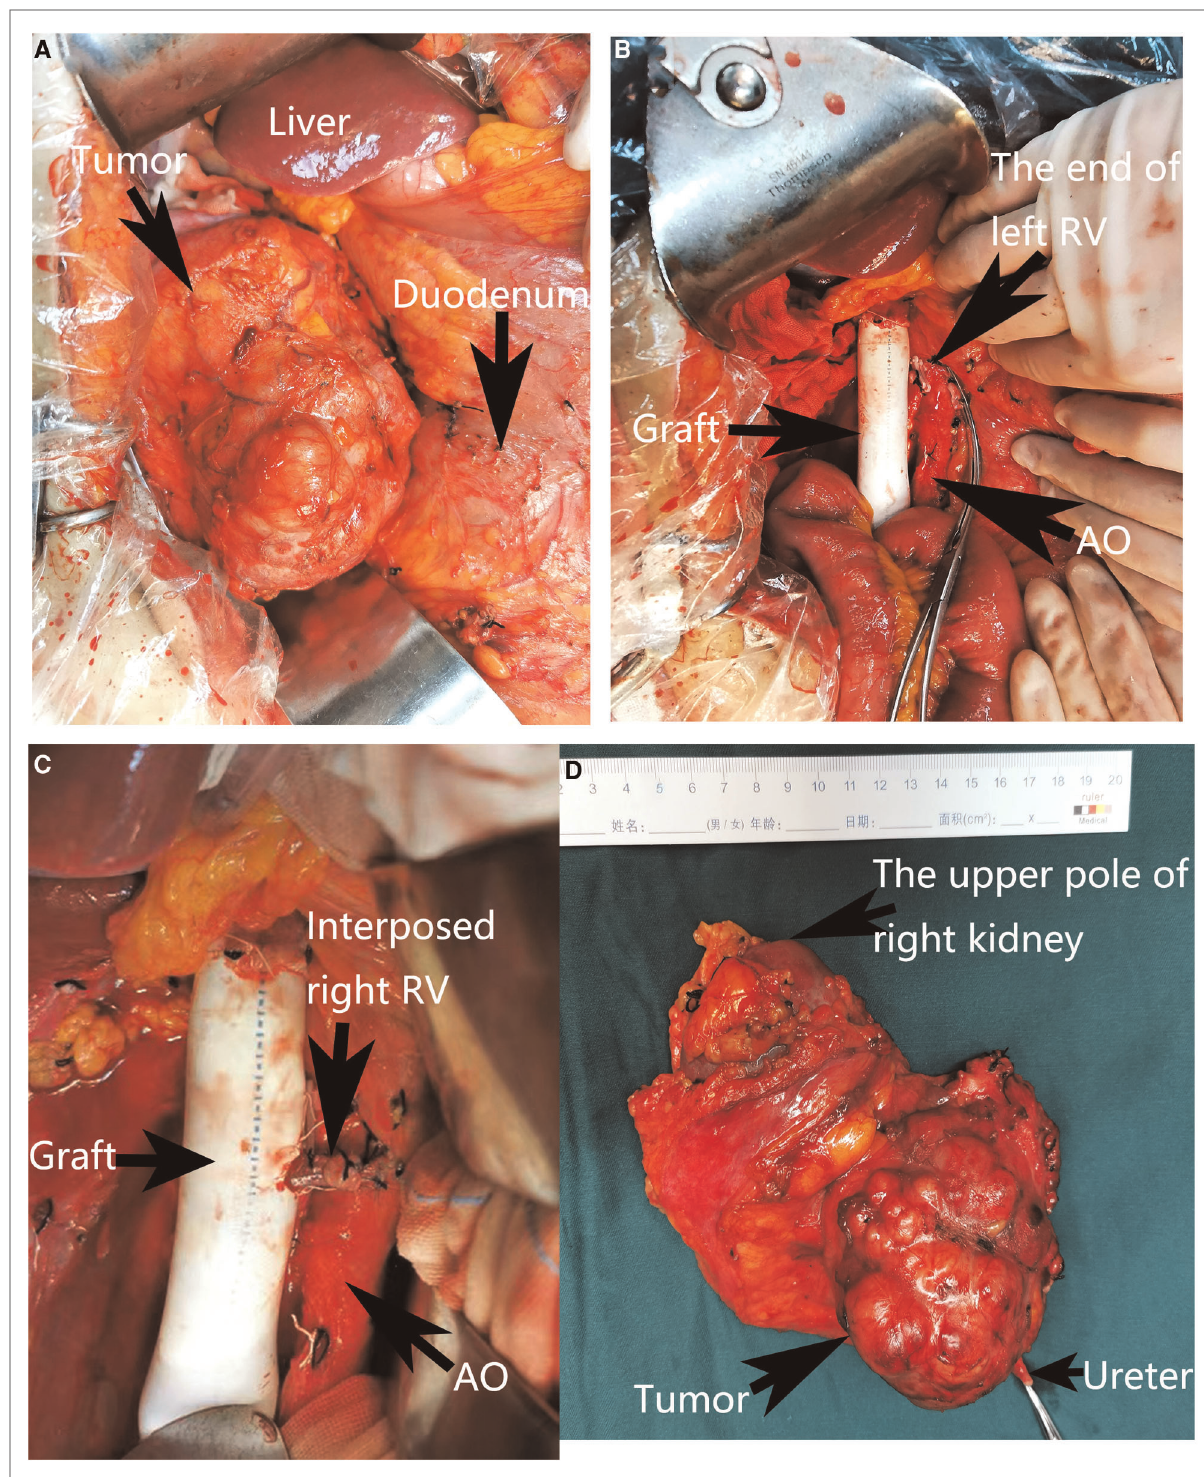
FIGURE 2 Intra-operative view. ( A ) The view before the excision. ( B ) Reconstruction of the inferior vena cava with an arti fi cial vascular graft. ( C ) Reimplantation of the left renal vein into the arti fi cial vascular graft by interposition of the right renal vein. ( D ) Resection of the tumor carrying the kidney with ureter. The adjacent viscera and main vessels were marked by arrows. RV, Right vein; AO, Aorta